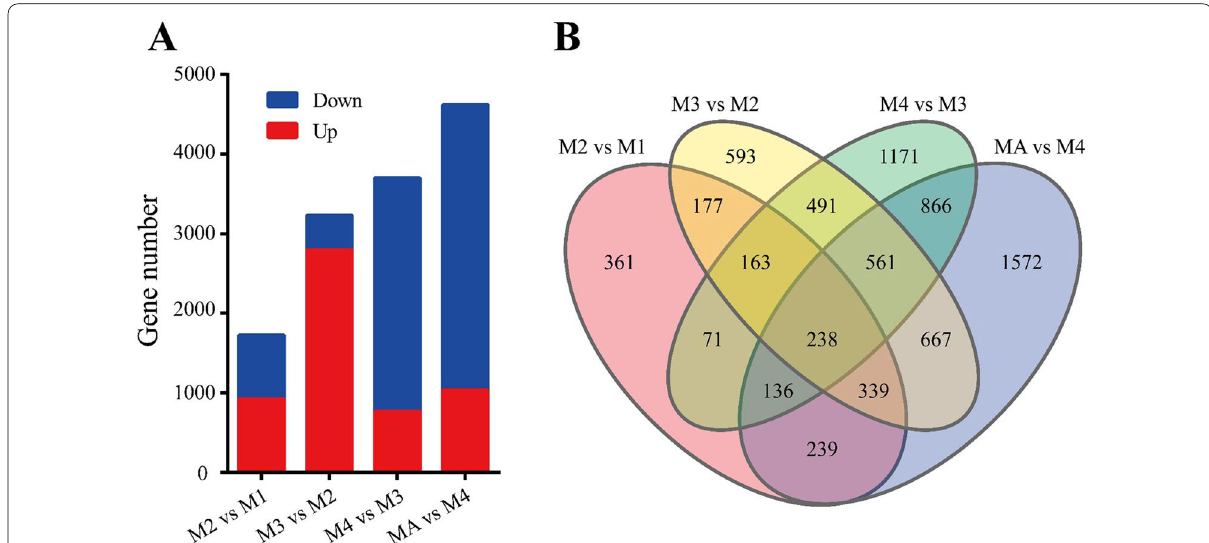
Fig. 7 Pairwise comparison of DEGs across the male development process. A The number of DEGs in the M2 vs. M1, M3 vs. M2, M4 vs. M3 and MA vs. M4. B Distribution of DEGs in the M2 vs. M1, M3 vs. M2, M4 vs. M3 and MA vs. M4. M1, M2, M3, M4 and MA represent the 1st, 2nd, 3rd, 4th instar nymphs and adult,